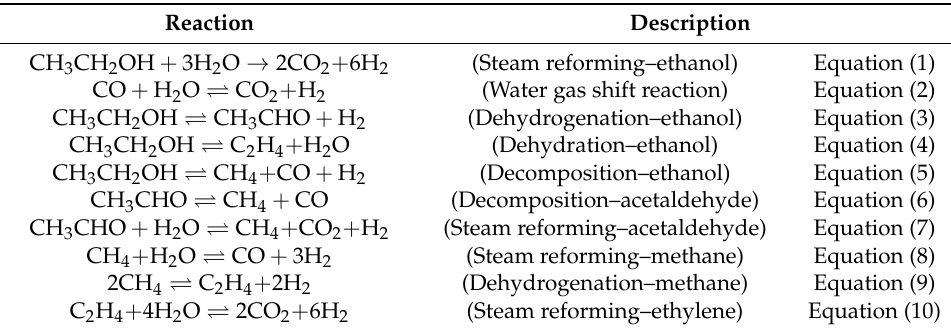
Table 1. Network of chemical reactions during the steam reforming of ethanol